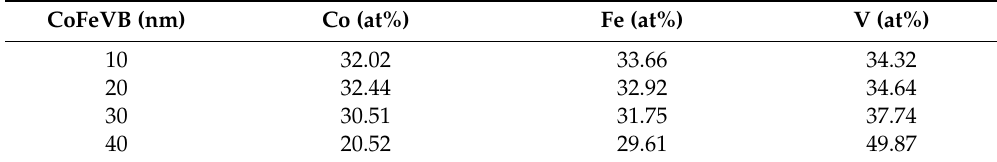
Table 1. EDX analysis data for the alloy films.